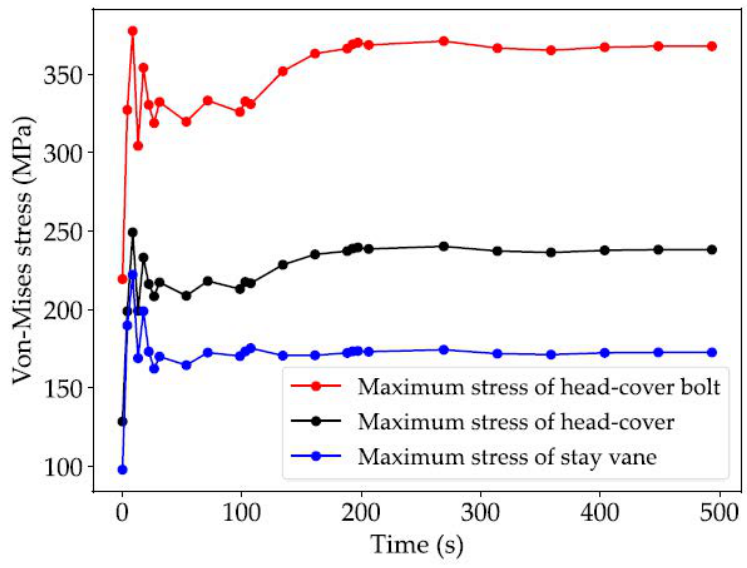
Figure 23. Comparison of the maximum stress during turbine start-up.